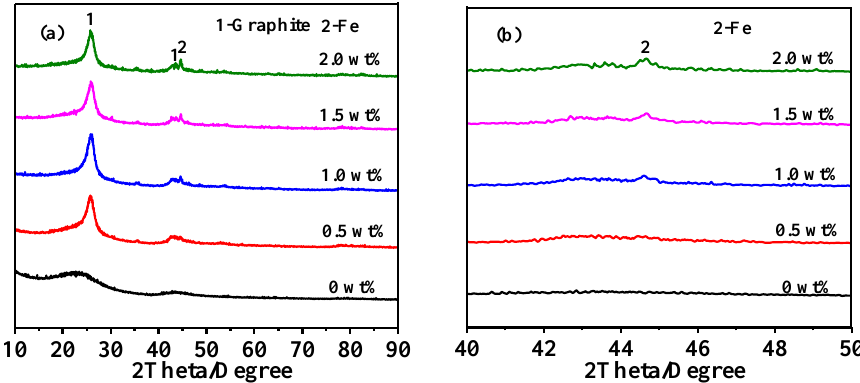
Figure 3. ( a ) XRD patterns of HGCS resulted from 3 h firing at 900 °C with various amounts of Fe catalyst and ( b ) magnification of the XRD patterns within 40°–50° (ICDD: 01-075-1621 (Graphite) and 01-089-7194 (Fe)).